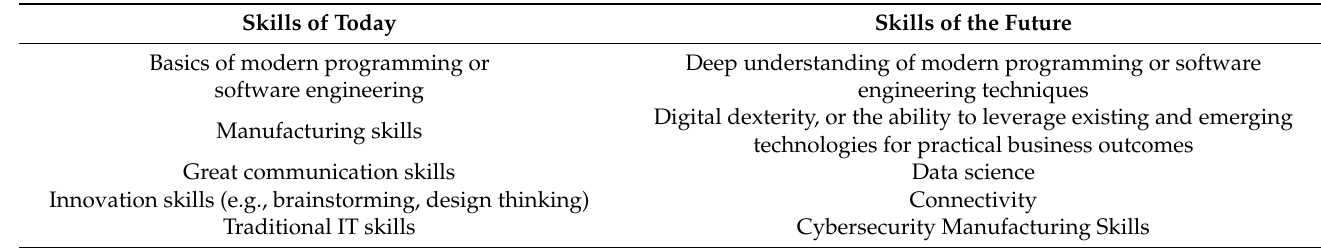
Table 5. Top five critical skills for today and the future